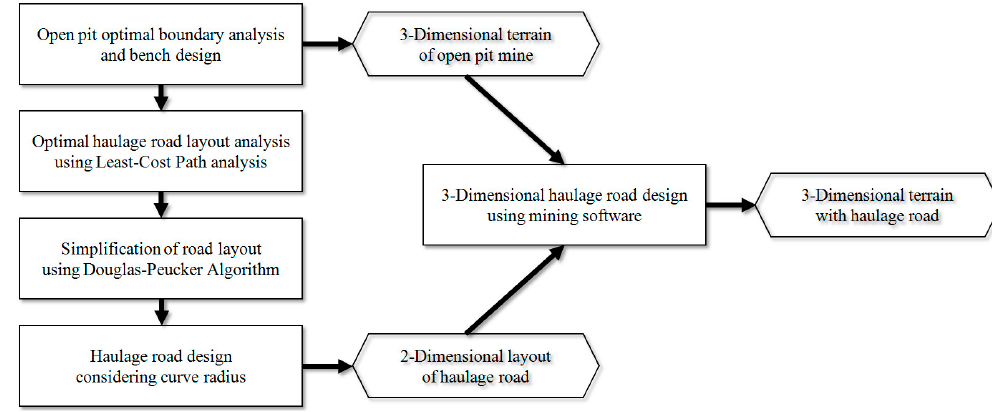
Figure 3. Study process of haul road design for open-pit mines using the proposed method.